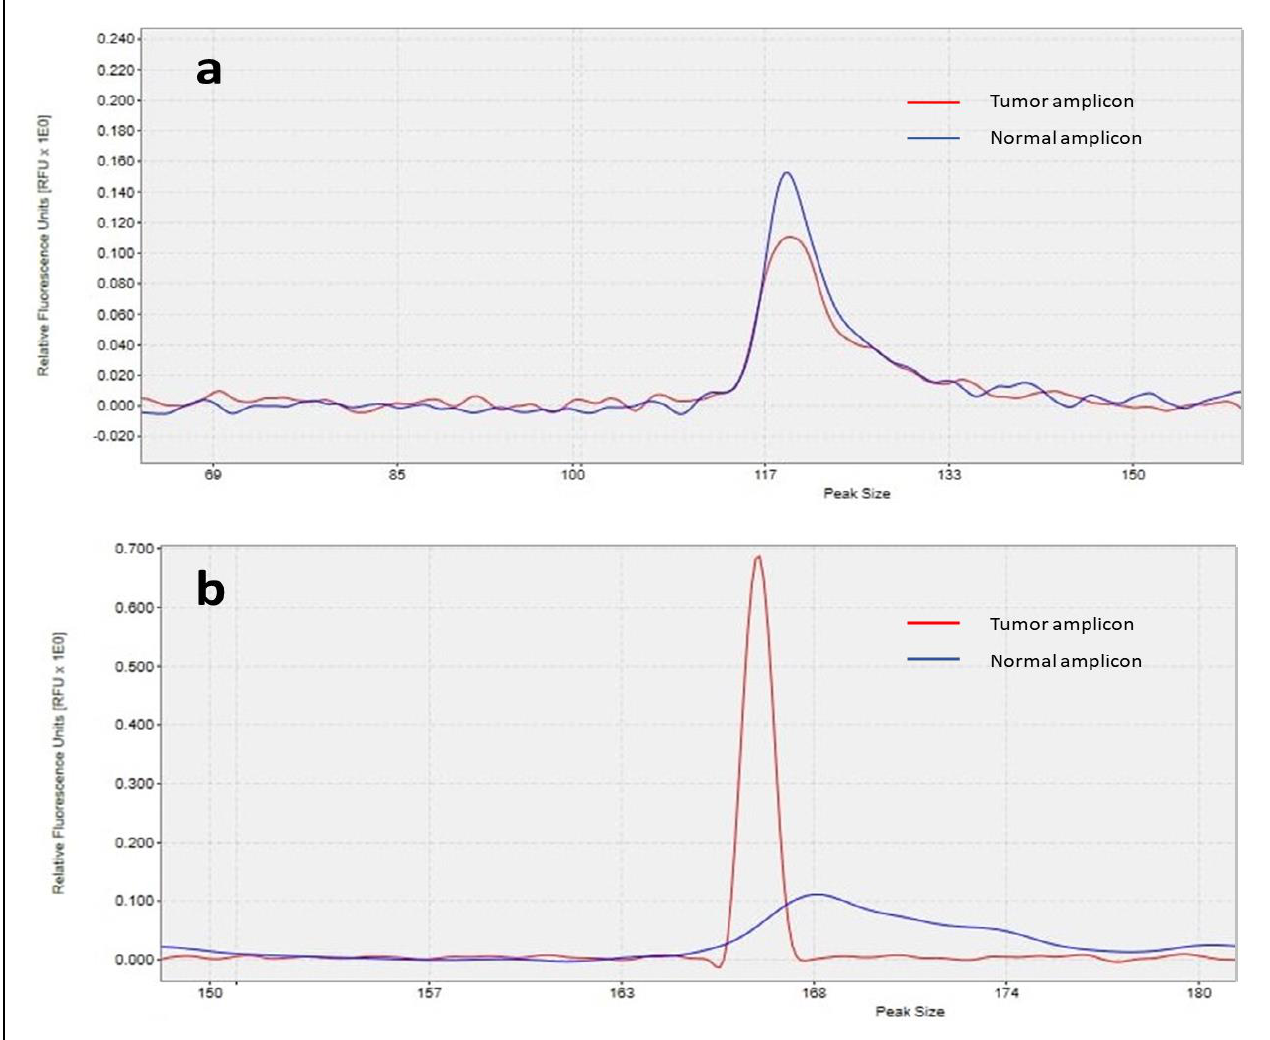
Figure 2: Electropherograms showing a) Stability of BAT-26 locus, b) Instability of D2S123 locus (Tumor and normal amplicons of each locus were superimposed on each other in the electropherogram determining either stability, if they coincide together, as in a) for BAT 26 locus, or instability, if they do not coincide, as in b) for D2S123 locus.; X-axis: Peak size, Y-axis: Relative fluorescence